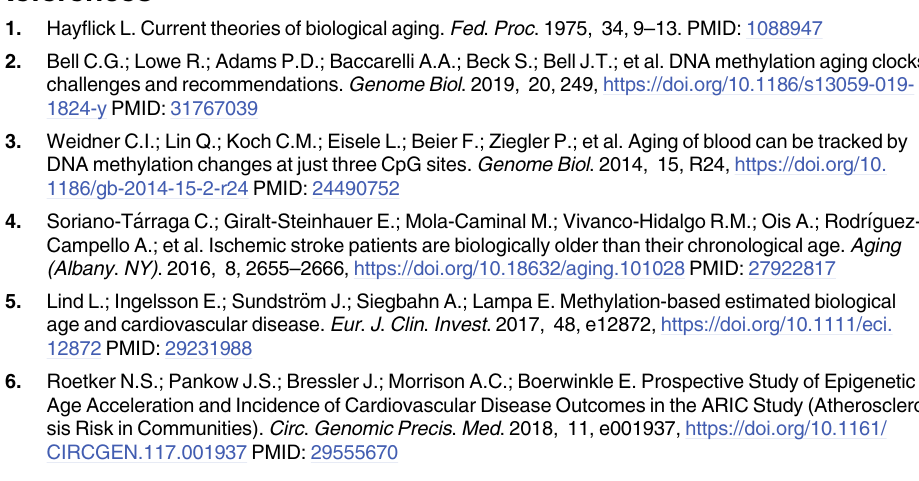
S2 Table. CpG associated with chronological age or histological